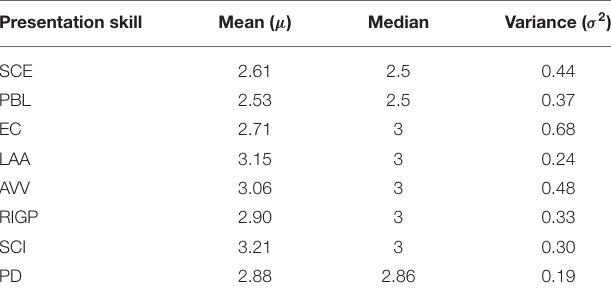
TABLE 1 | Score assigned by tutors to students’ presentation